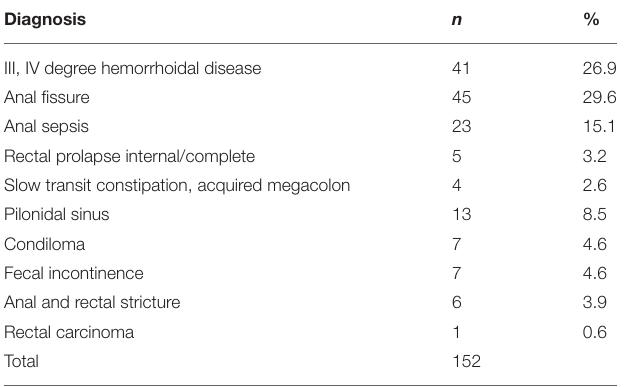
TABLE 3 | Data from 152 clinical records pre-lockdown (84M, 68F).